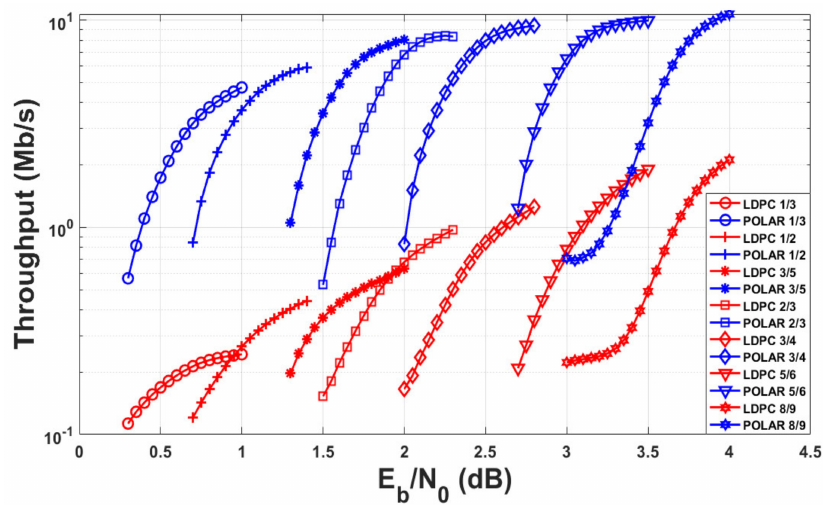
Figure 11. Throughput versus E b / N 0 for LDPC and optimized polar codes using short frame with N = 16,200 and different code rates R in DVB-S2.